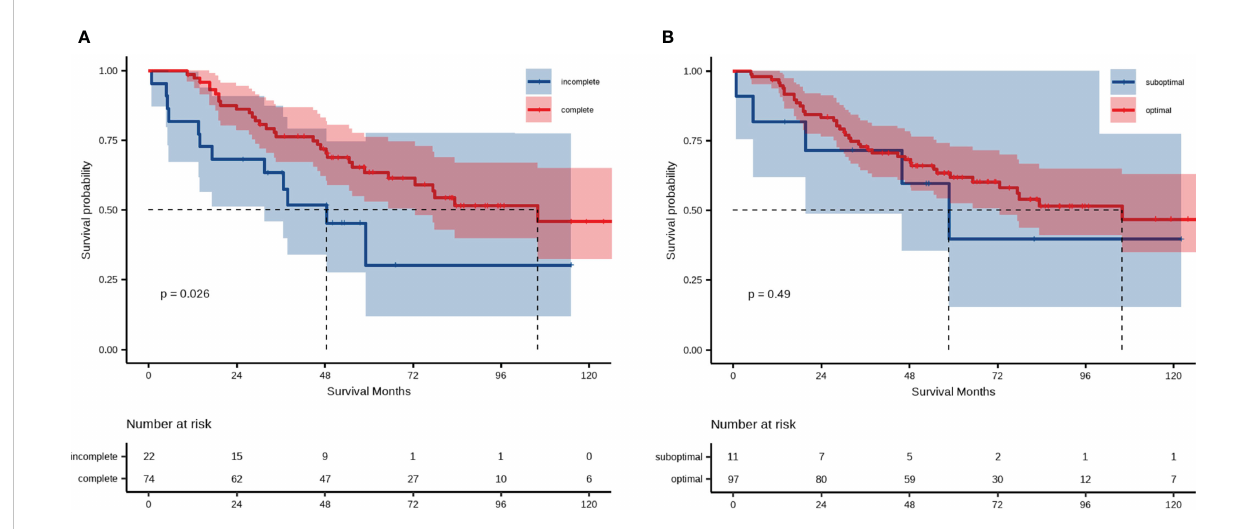
FIGURE 4 Analysis of overall survival of patient groups categorized according to LMR and (A) administration of postoperative adjuvant chemotherapy or (B) residual